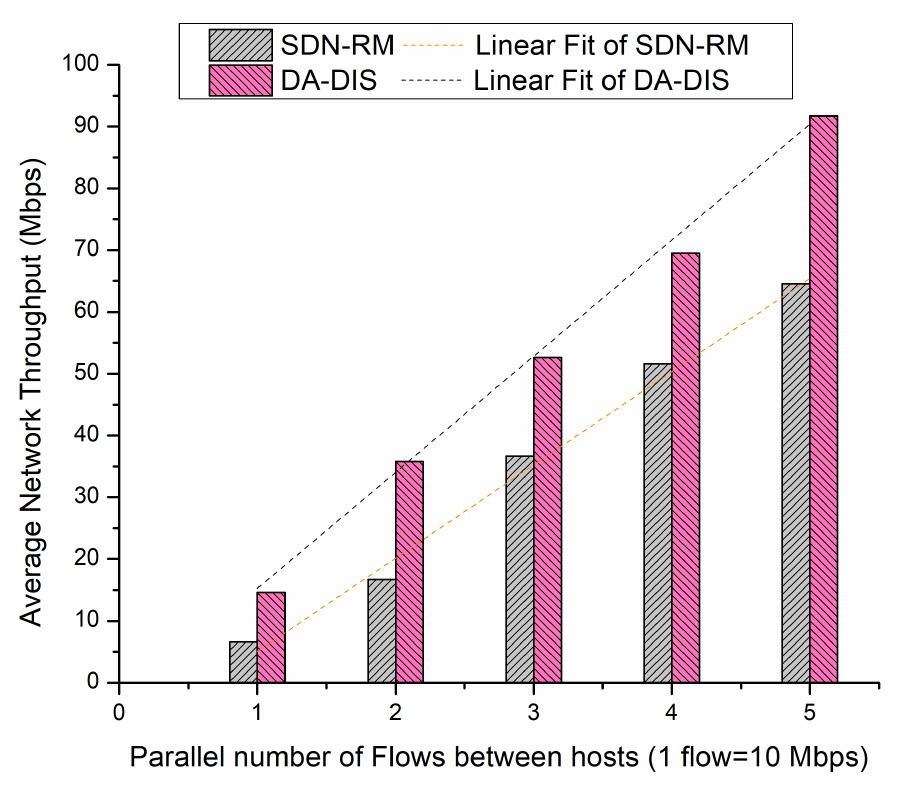
Figure 21. Throughput considering different numbers of parallel flows with one malicious switch along with E2 category